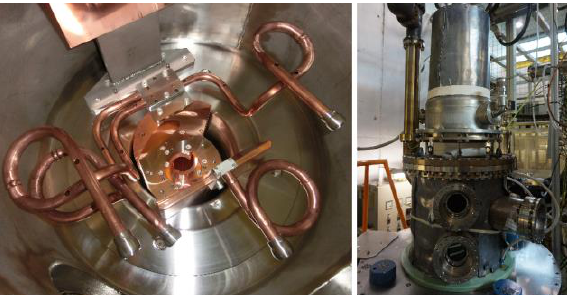
Fig. 4. Upgrades on the SP gyrotron: internal pipes inside the mirror box (left) and gyrotron equipped with an isolated collector and cryostat insulating ring (right).